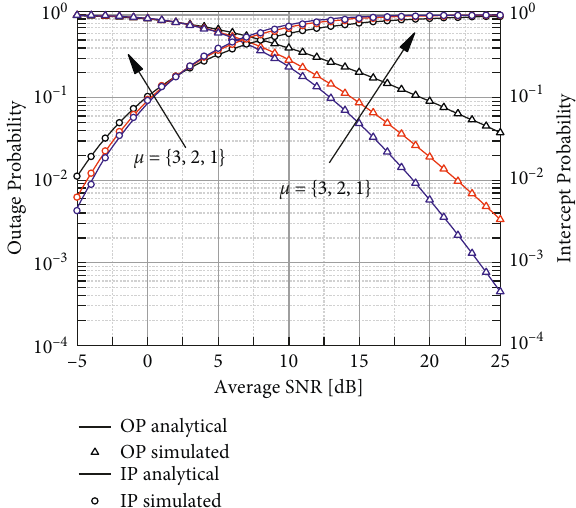
Figure 5: OP and IP versus average SNR for various values of m .